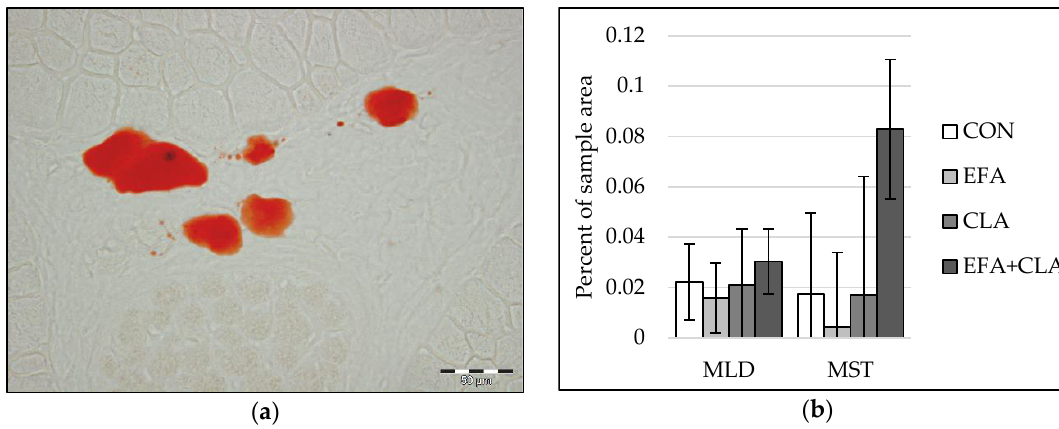
Figure 5. Intramuscular fat in longissimus (MLD) and semitendinosus muscle (MST) of calves of four